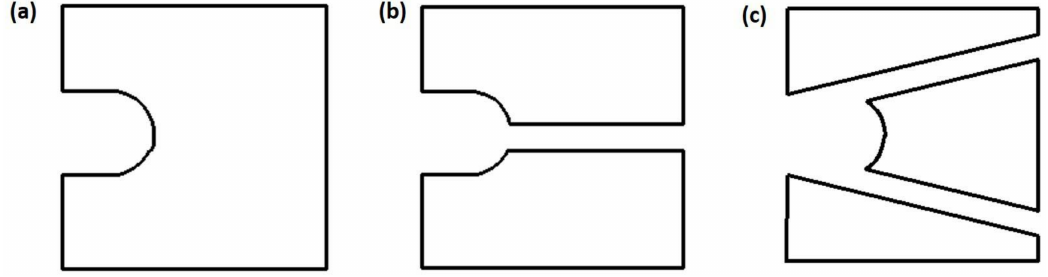
Figure 1. The schematic diagram of three types of capture structures: ( a ) seamless; ( b ) single-slit; ( c )